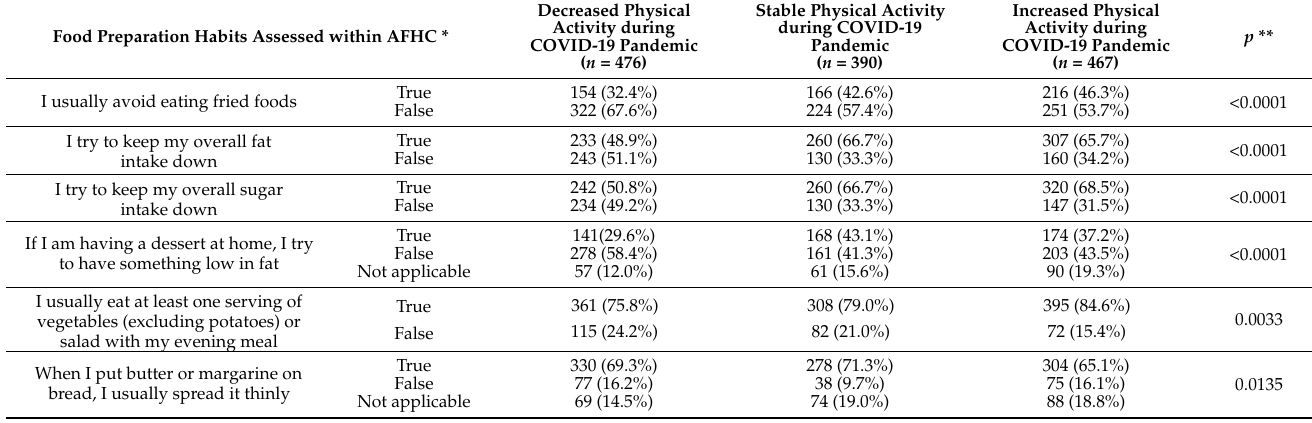
Table 8. The food preparation habits assessed while using Adolescents’ Food Habits Checklist (AFHC) in the period during the COVID-19 pandemic, as declared by the adolescents from the Diet and Activity of Youth during COVID-19 (DAY-19) Study cohort ( n = 1333) in sub-groups of adolescents declaring decreased, stable, and increased physical activity during the COVID-19